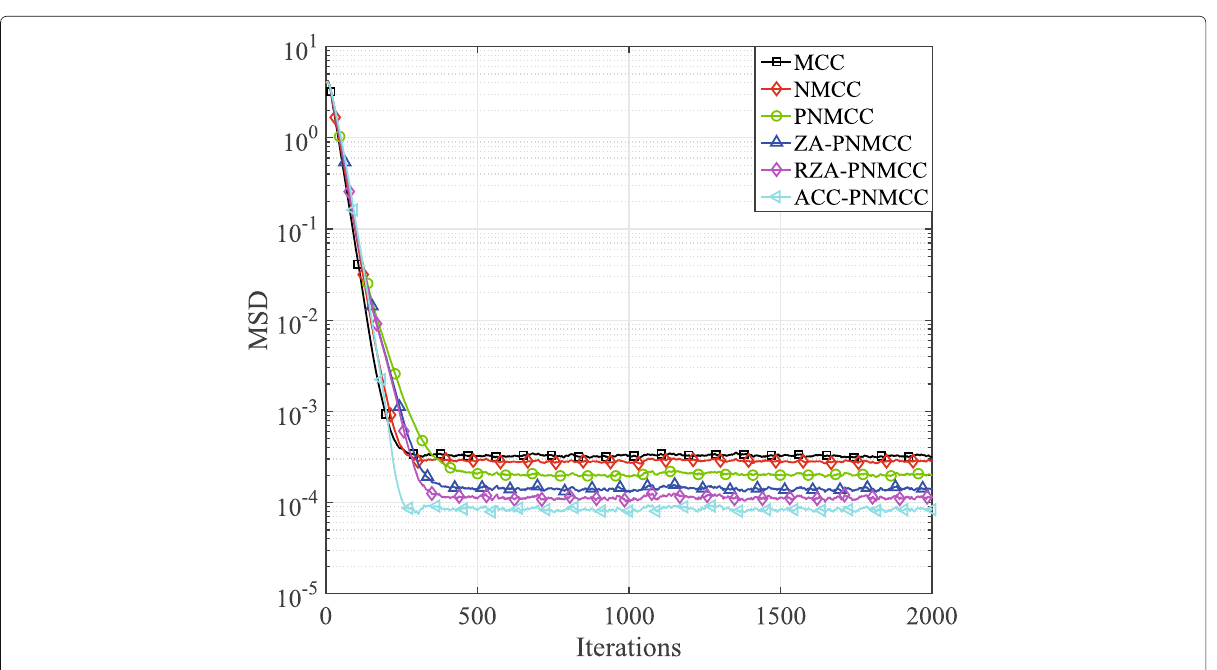
Fig. 6 The MSD performance of the proposed ACC-PNMCC algorithm with K =